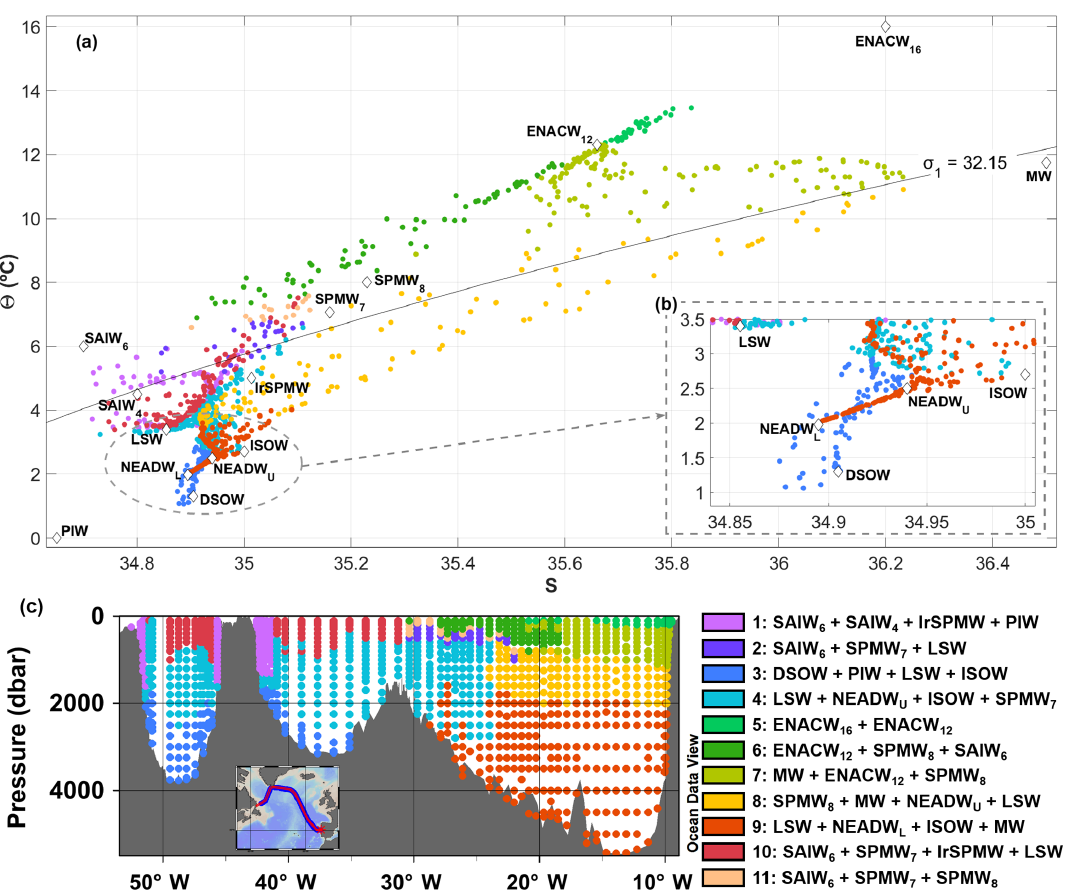
Figure 3. (a) Potential temperature ( θ) –salinity (S) diagram including the source water types (SWTs; Table 1) and (b) zoomed for deep waters. The isopycnal σ 1 = 32.15kgm − 3 delimiting the upper and lower limbs of the AMOC at the GEOTRACES-GA01 section is also plotted. Colour coding represents the mixing groups (legend on c ), i.e. subsets of SWTs susceptible of mixing together. (c) Distribution of the mixing groups along the GEOTRACES-GA01 section